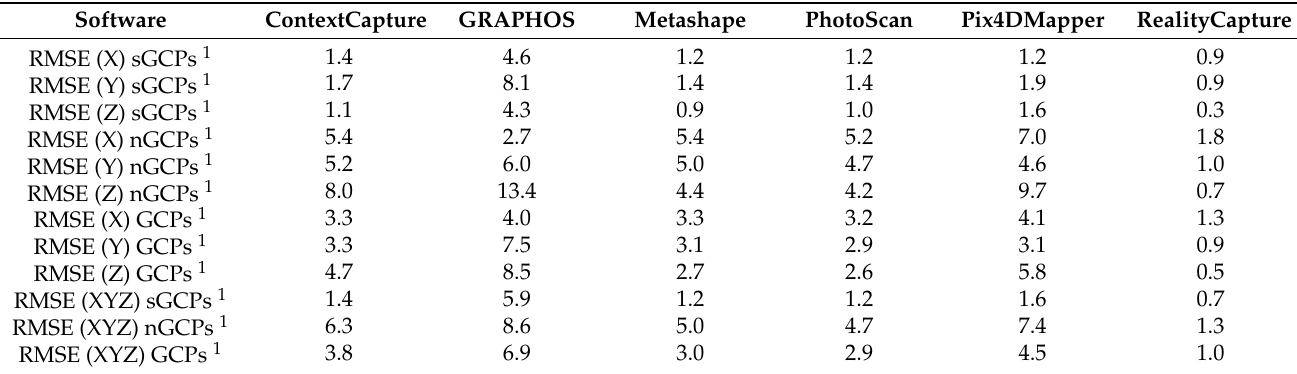
Table 4. The RMSE values on GCPs obtained in tested software after BBA.